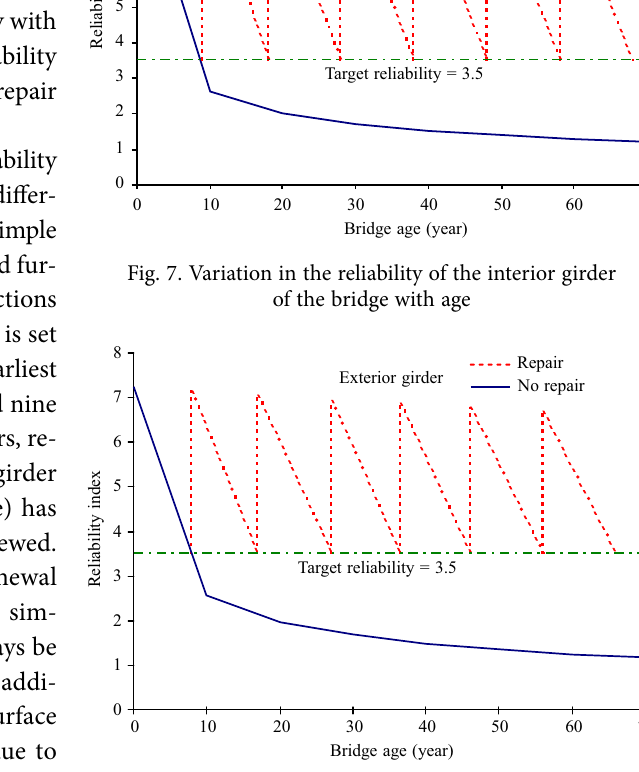
Fig. 8. Variation in the reliability of the exterior girder of the bridge with age